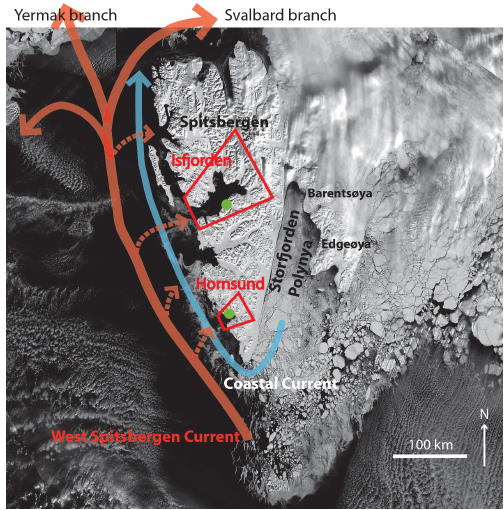
Figure 1. MODIS image of Svalbard taken on 8 April 2009 in- cluding a schematic illustration of the ocean currents along western Spitzbergen. The two considered fjords Isfjorden and Hornsund are marked with red polygons. The respective weather stations, marked with green dots, are located at 78.25 ◦ N, 15.50 ◦ E (Isfjorden) and 77.00 ◦ N, 15.54 ◦ E